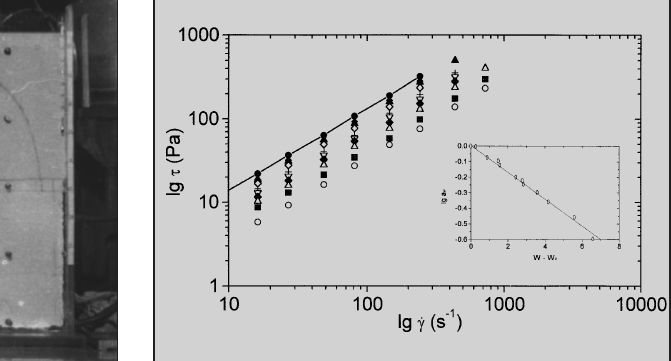
Figure 2 (left): Model device of the alternate drainage viscous model. Figure 3 (right): Flow curves of the model fluid for different moisture